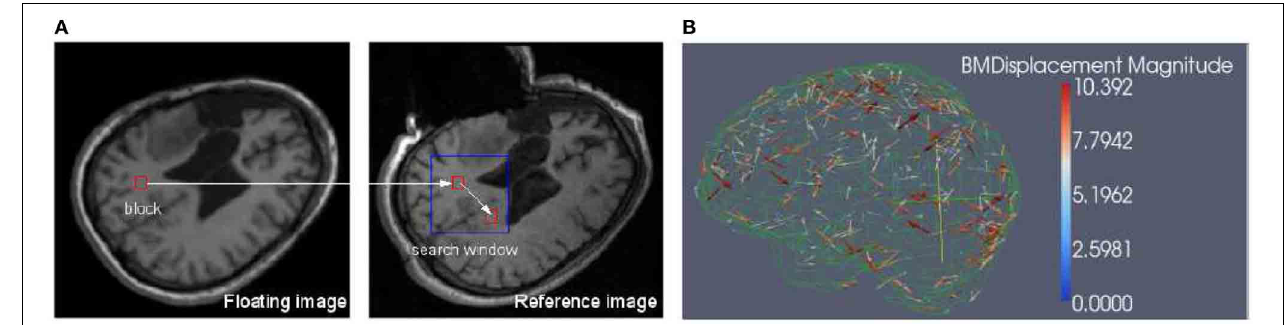
FIGURE 1 | (A) Block matching. For a small block in the floating image, find its corresponding block in a predefined search window in the reference or fixed image, then the displacement associated with the block can be calculated. The block can be specified in both floating and reference images